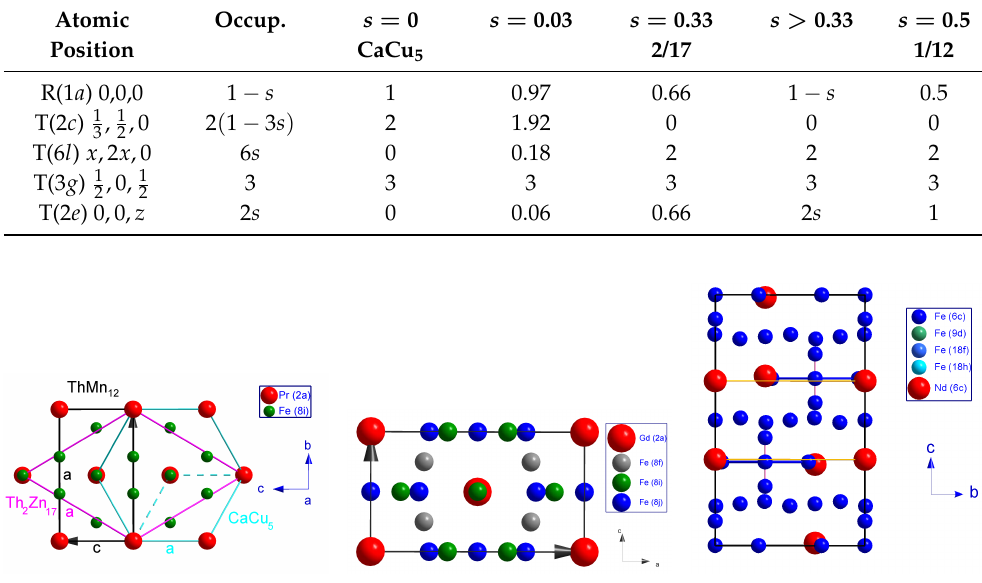
Figure 2. ( Left ) Schematic representation of the relationship between CaCu 5 (along [001] axis) Th 2 Zn 17 (along [001] axis) and ThMn 12 (along [010] axis) structures, ( Center ) illustration of atomic arrangements in GdFe 10 Cr 2 crystal structure along [010] axis, and ( Right ) the rhombohedral R ¯3 m crystal structure of Nd 2 Fe 17 along [100]